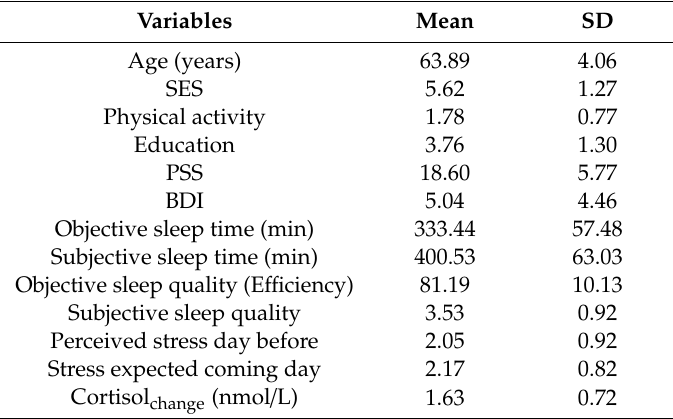
Table 1. Characteristics of the